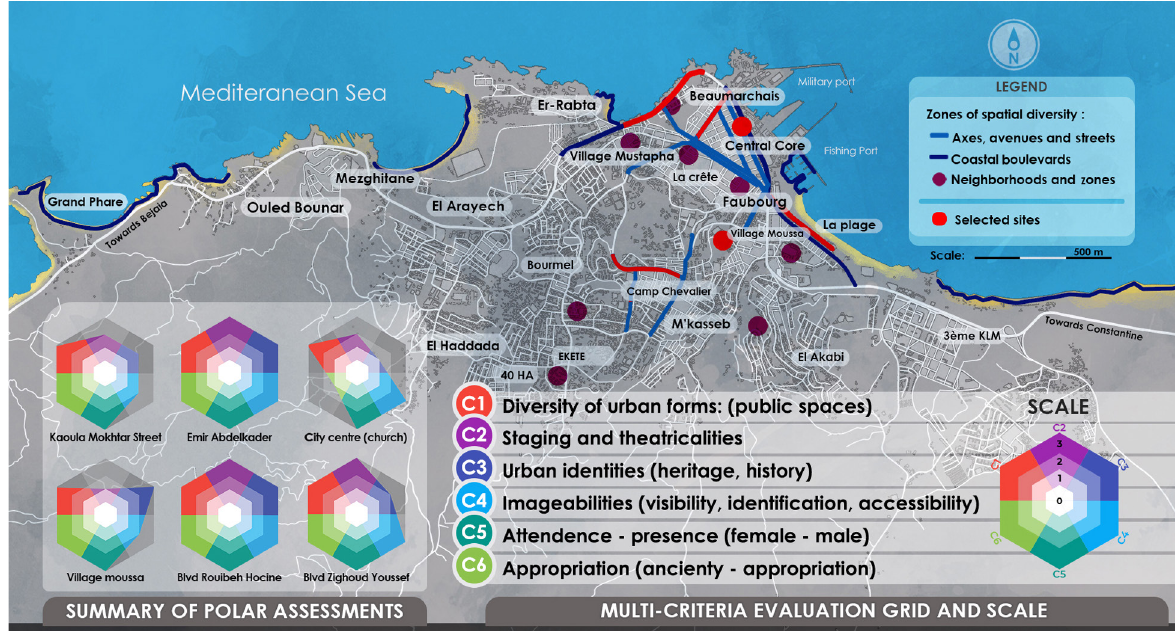
Fig. 1. Situation of spatial diversity zones (by category) and the selected sites. Multi-criteria evaluation grid (criteria and scale) and results of the selected sites. Source: own